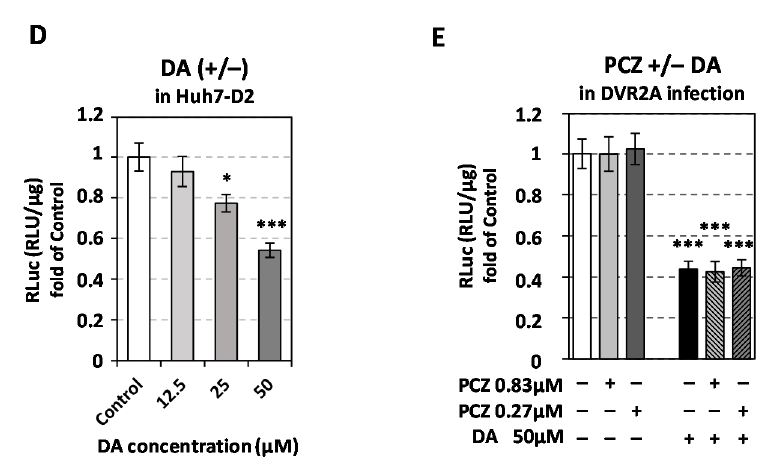
Figure 5. DDC enzyme activity products reduce DV replication. Huh7 cells were inoculated with DVR2A (MOI = 0.1) ( A , E ) or DV (MOI = 0.1) ( B , C ) for 4 h, and subsequently treated with the pointed concentrations of DA, 5-HT and/or PCZ, for 48 h. Mock-treated cells were used in parallel. ( A ) RLuc activity, indicative of viral replication, was quantified in cells cultured in the presence of DA (left) or 5-HT (right), or in mock-treated cells (Control). ( B ) RT-qPCR analysis was performed to determine DV plus-strand RNA levels in cells treated with DA or mock-treated (Control). ( A , B ) Control cell values were set as one. Data shown are means ± standard deviations of values from three independent experiments in triplicate. * p < 0.05, ** p < 0.01, *** p < 0.01 vs. Control. ( C ) SDS-PAGE and immunoblot analysis were carried out in lysates of DV-infected cells treated for 48 h with 25 µ M or 50 µ M DA, or mock-treated (Control), with the use of antibodies against DV NS3, DDC, or β -actin (loading control) proteins. An experiment that is representative of three independent repetitions is shown. ( D ) The Huh7-D2 cell line was treated for 48 h with the pointed concentrations of DA or mock- treated (Control). Levels of Renilla luciferase activity were calculated as RLU/ µ g of total protein amount. ( E ) Dopamine affects DV replication possibly through its uptake and not via its receptor signaling. Effect of DA and PCZ combination on DVR2A replication. DV-infected mock-treated cell (Control, ( − )) values were expressed as one. ( D , E ) The mean values ± standard deviations from three biologically independent experiments in triplicate are presented. * p < 0.05, *** p < 0.001 vs. Control ( −